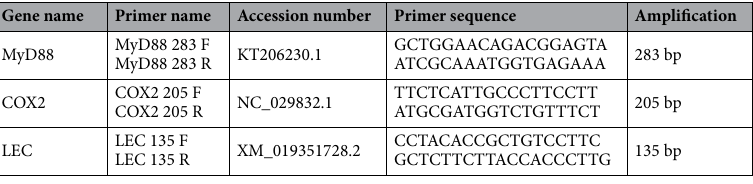
Table 1. Primers used for